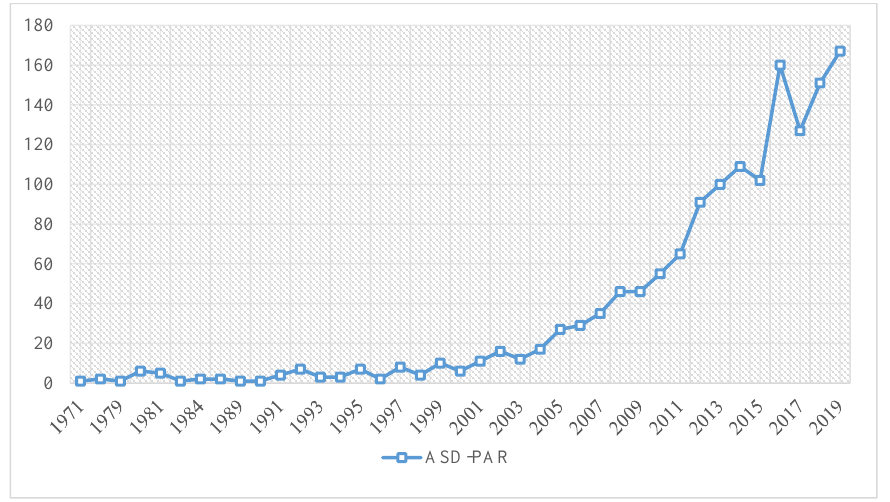
Figure 2. Evolution of scientific production. Note: Y -axis: number of manuscripts; X -axis: dates of publication. Table 2. Scientific language of publications.